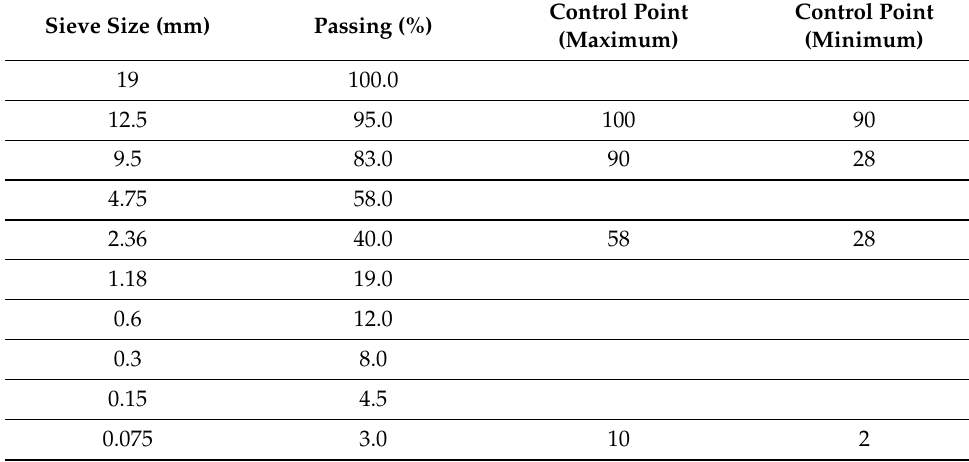
Table 3. Aggregate size